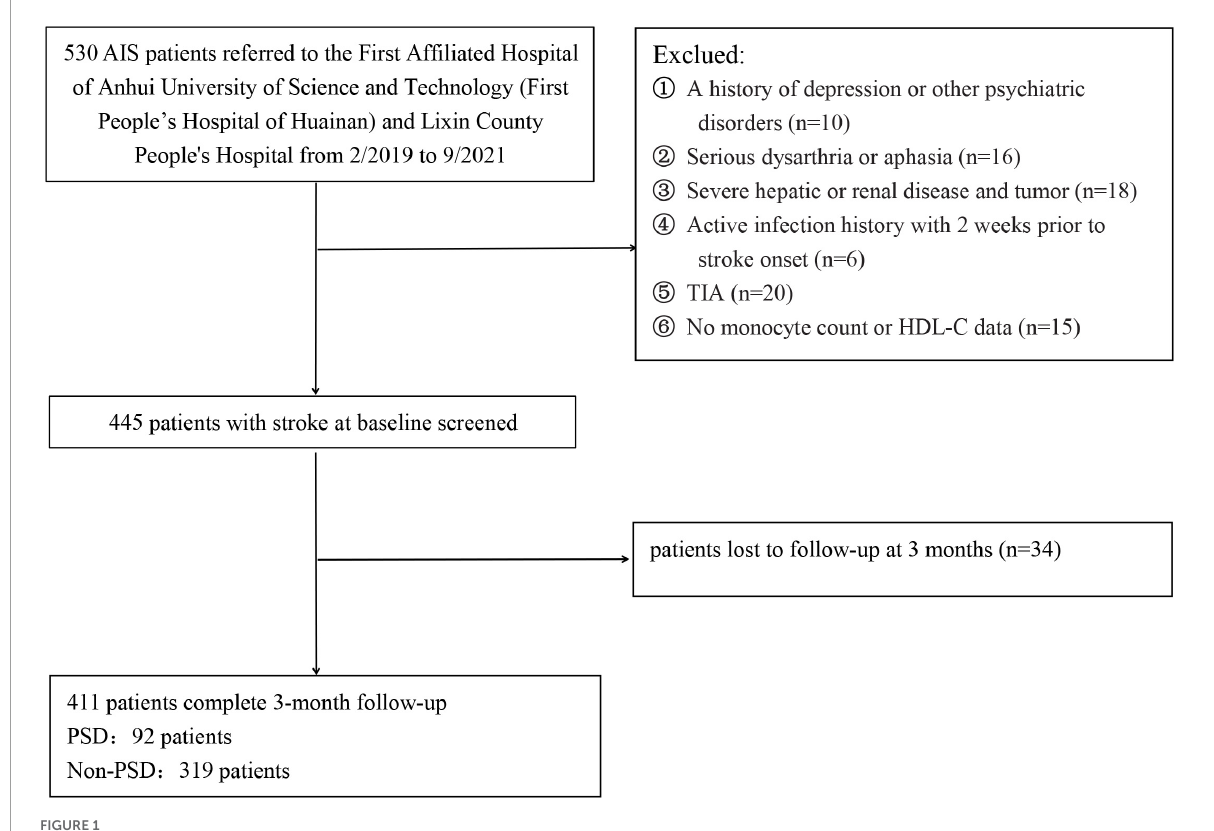
FIGURE1 Flowchart of participant